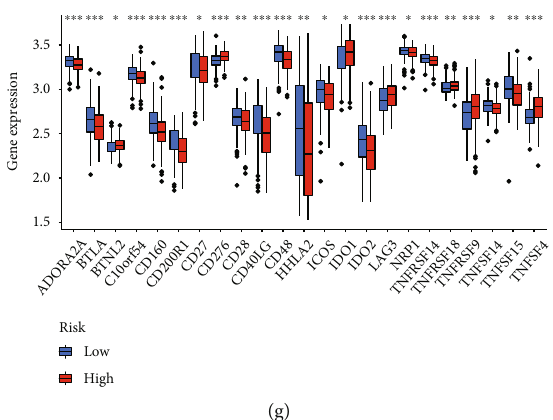
Figure 4: Analysis of immunity. (a) The relationships between in fi ltration of immune cells and risk score. (b) The relationship between in fi ltration of stromal cells and risk score. (c) TIDE scores of two groups. (d) Immune cells in TCGA data set. (e) Immune cells in GSE72094. (f) Di ff erentially expressed immune checkpoints in TCGA data set. (g) Di ff erentially expressed immune checkpoints in